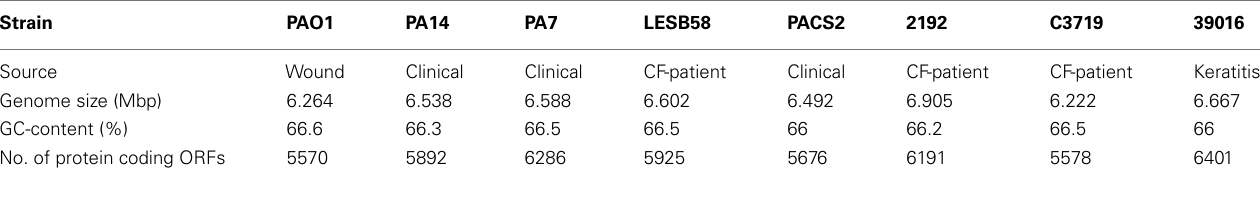
Table 1 | Features of sequenced P. aeruginosa